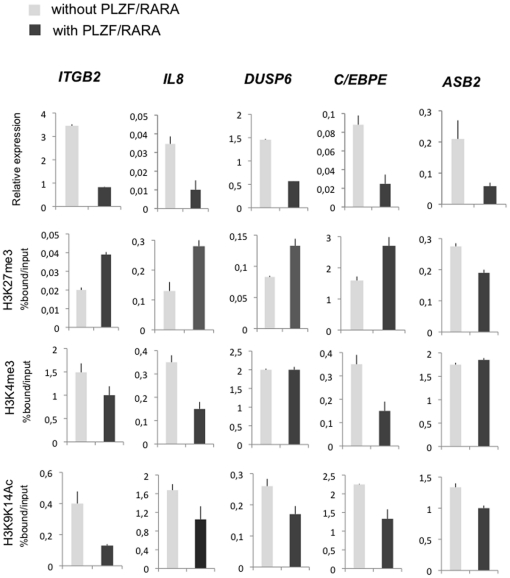
Validation of gene expression and chromatin modification changes at PLZF/RARA target genes.Zinc-induced U937-MT cells (light grey bars) or U937-B412 cells (dark grey bars) were analysed as follows. For mRNA expression level, RNA was extracted and reverse-transcribed; the selected target genes were analyzed by qRT-PCR. Gene expression of each gene is shown relative to HPRT expression. For epigenetic marks, H3K27me3, H3K4me3 and H3Ac were analysed by ChIP-qPCR at the indicated promoter.